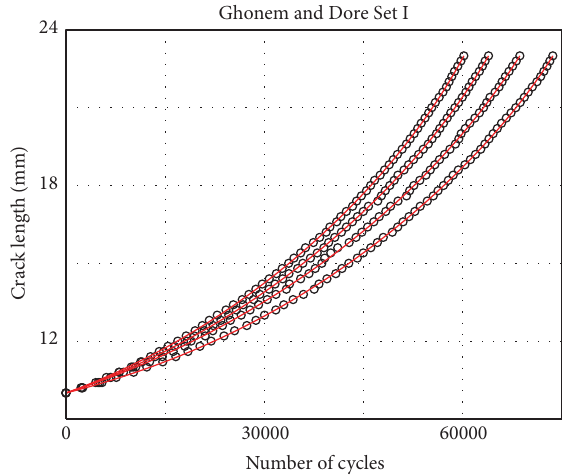
Figure 2: Four sets of crack growth data from Ghonem and Dore’s dataset [47]: raw data (dots) and analytical model